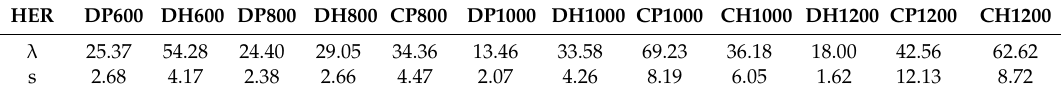
Table A11. Hole expansion ratios (HER) λ according to EN ISO 16630 [32] ( n = 30).